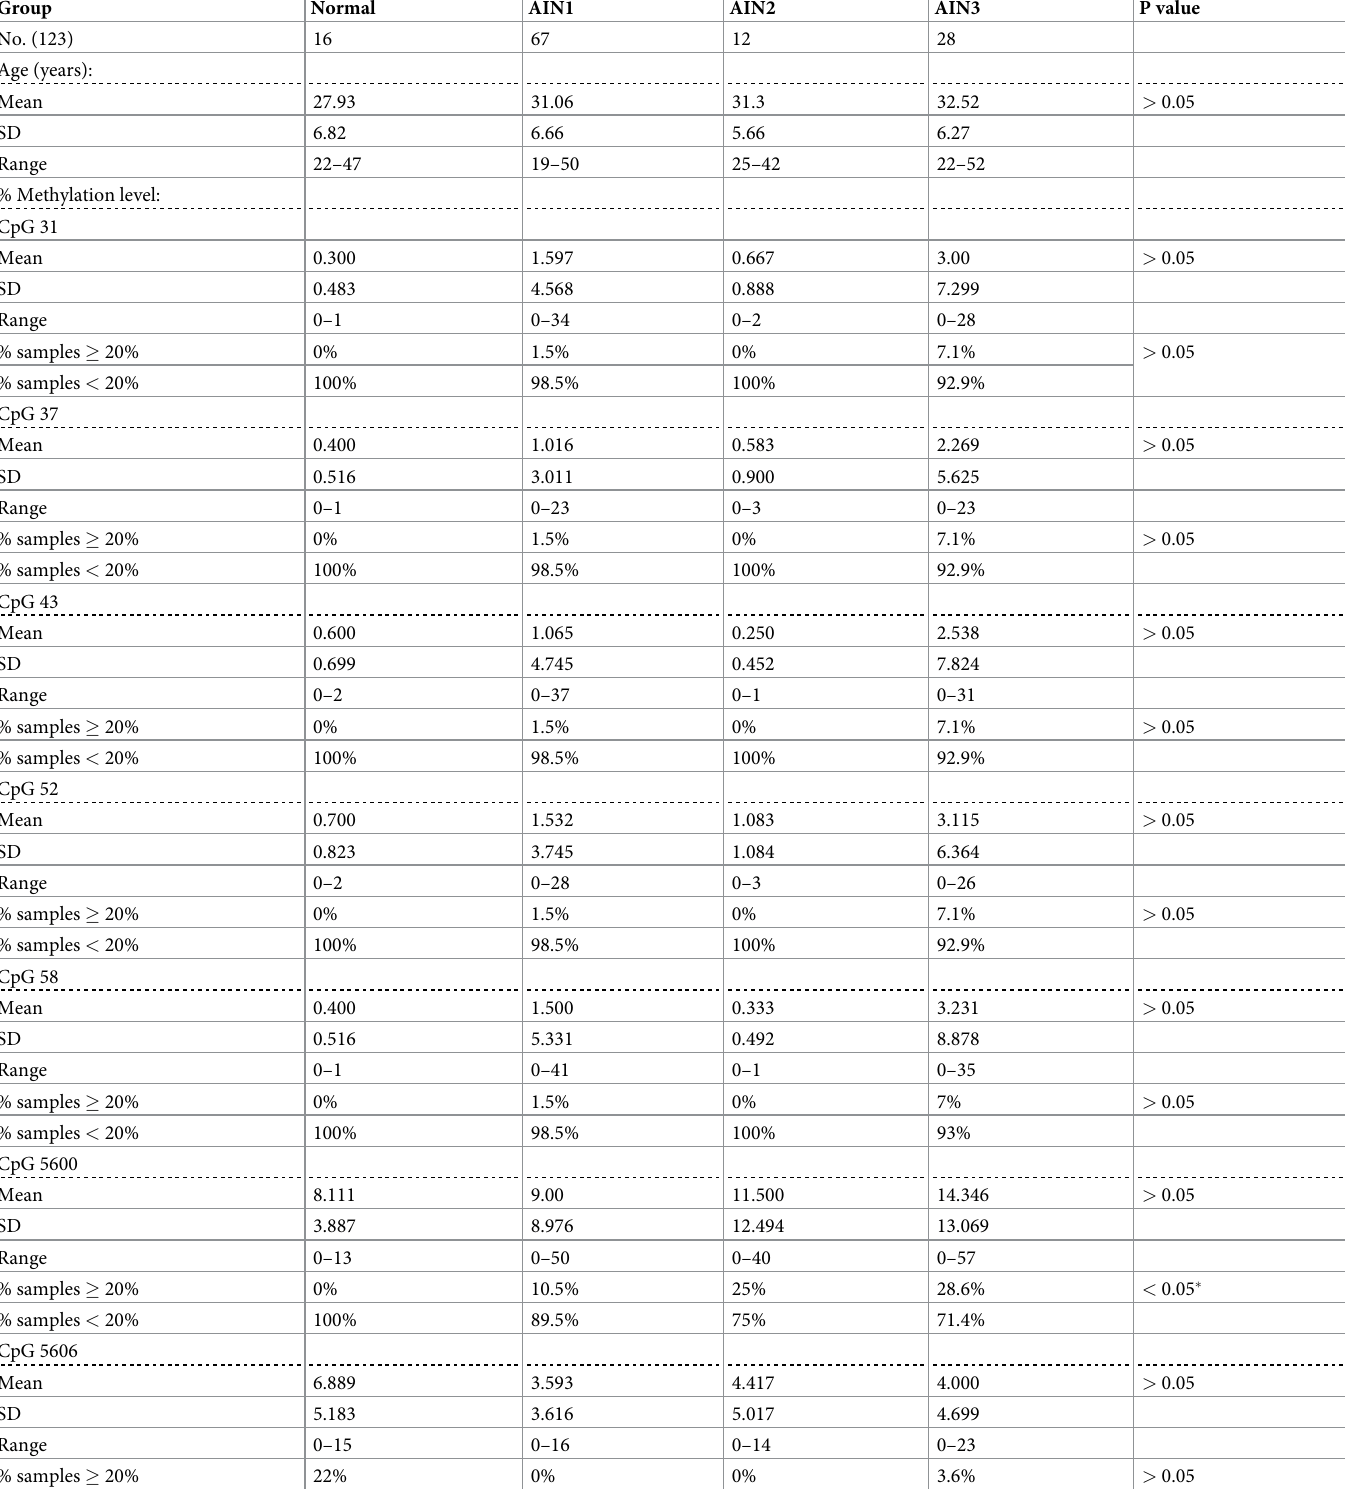
Table 2. Patient age and methylation status of the HPV16 early promoter and the L1 genes in anal cells with various grades of lesions.